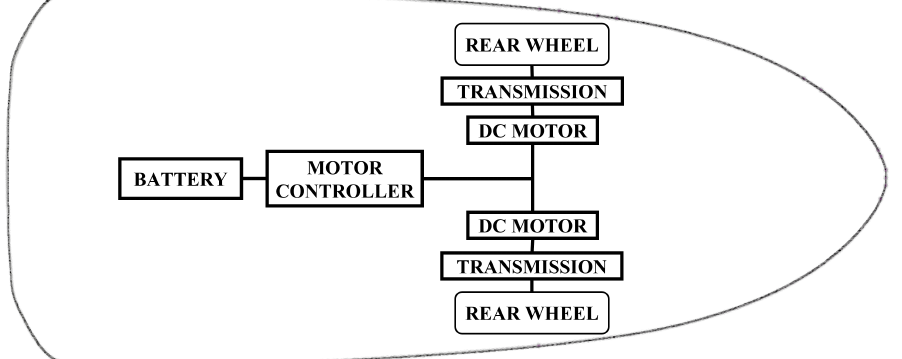
Figure 2. Powertrain